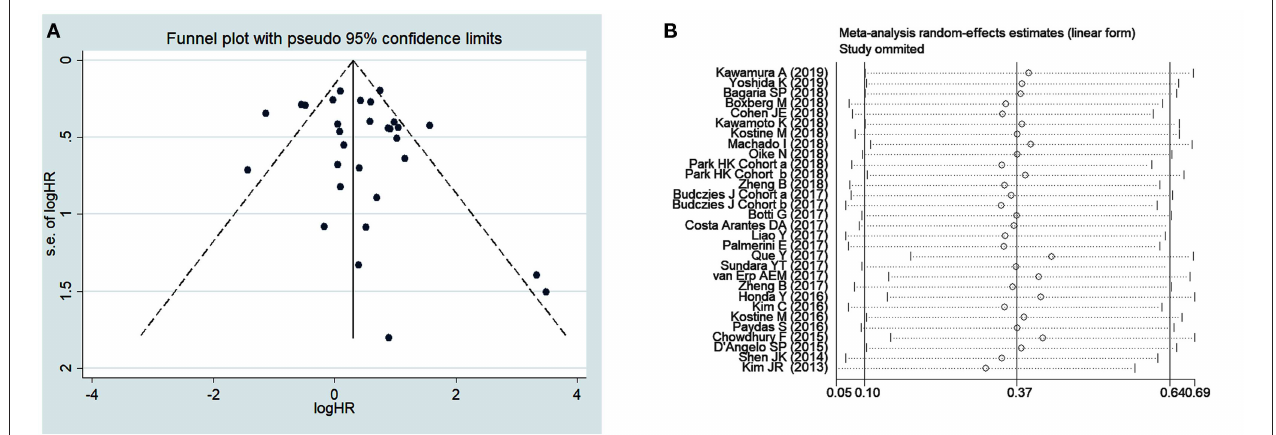
FIGURE 3 | Funnel plots for publication bias (A) and sensitivity analysis (B) of overall survival.